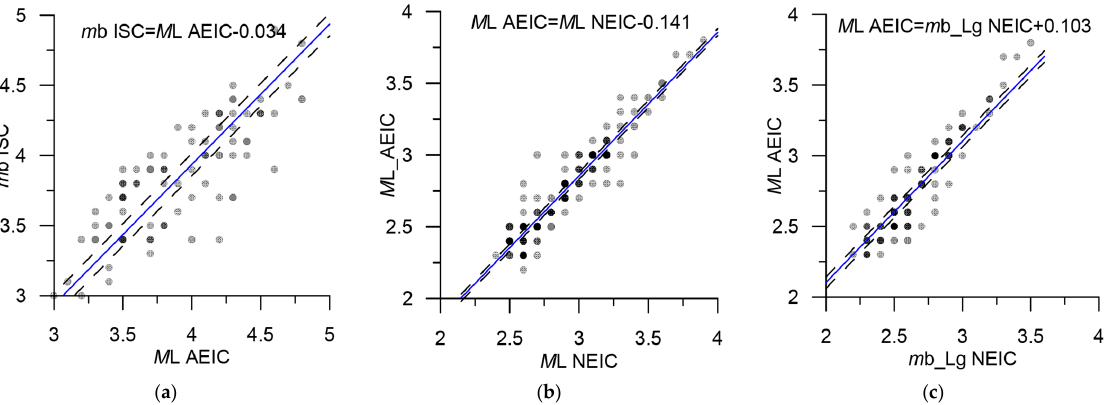
Figure 16. Correlation ratios “shift” of the magnitudes YARS and mb ISC . ( a ) ML YARS . ( b ) MSV YARS . The dashed lines show 95% confidence intervals.